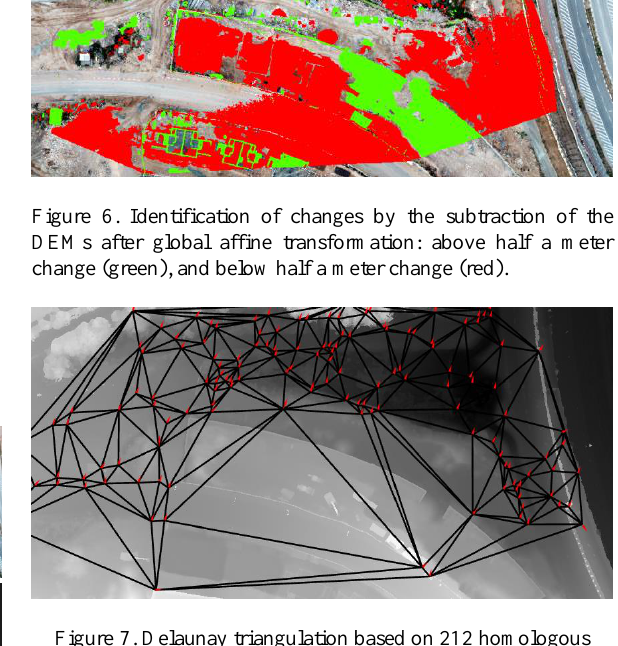
Figure 7. Delaunay triangulation based on 212 homologous points superimposed on the DEM.